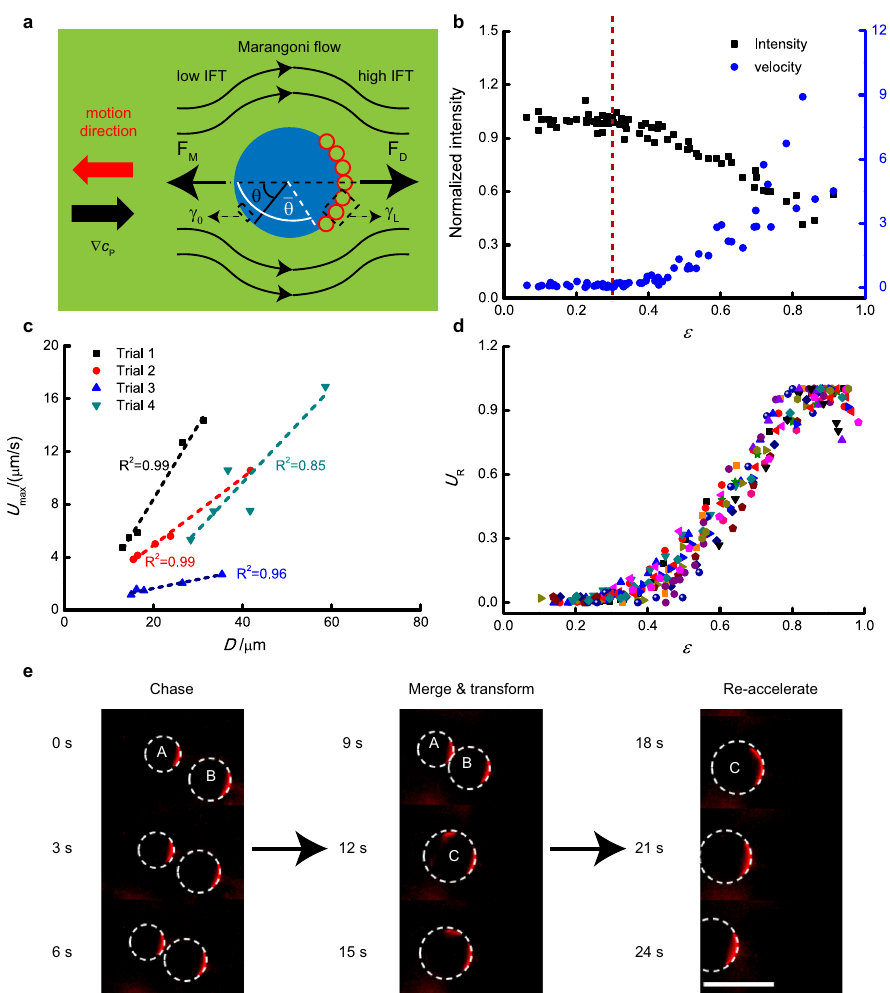
Fig. 4 Mechanism behind motion. a Illustration for the Marangoni effect. F M is the force induced by Marangoni stresses, while F D is the viscous drag force. γ γ L and 0 is the interfacial tension between PEG-rich and DEX-rich phase with or without the presence of liposomes. b The total intensity of liposome coating and corresponding droplet velocity ( U ) for different droplets. c The relationship between maximum velocity ( U max ) and droplet diameter ( D ). The difference in the slope for different batches is due to the variations in polymer gradients. d The relationship between normalised velocity ( U R , the ratio of droplet velocity at different time points to its maximum velocity) and the value of ε ( h / D ). 20 droplets from four trials were chosen for analysis. e Chasing and merge process for two droplets with different diameter. Pictures were extracted from Supplementary Movie 6 and cropped for better presentation. Scale bar is 50 μ